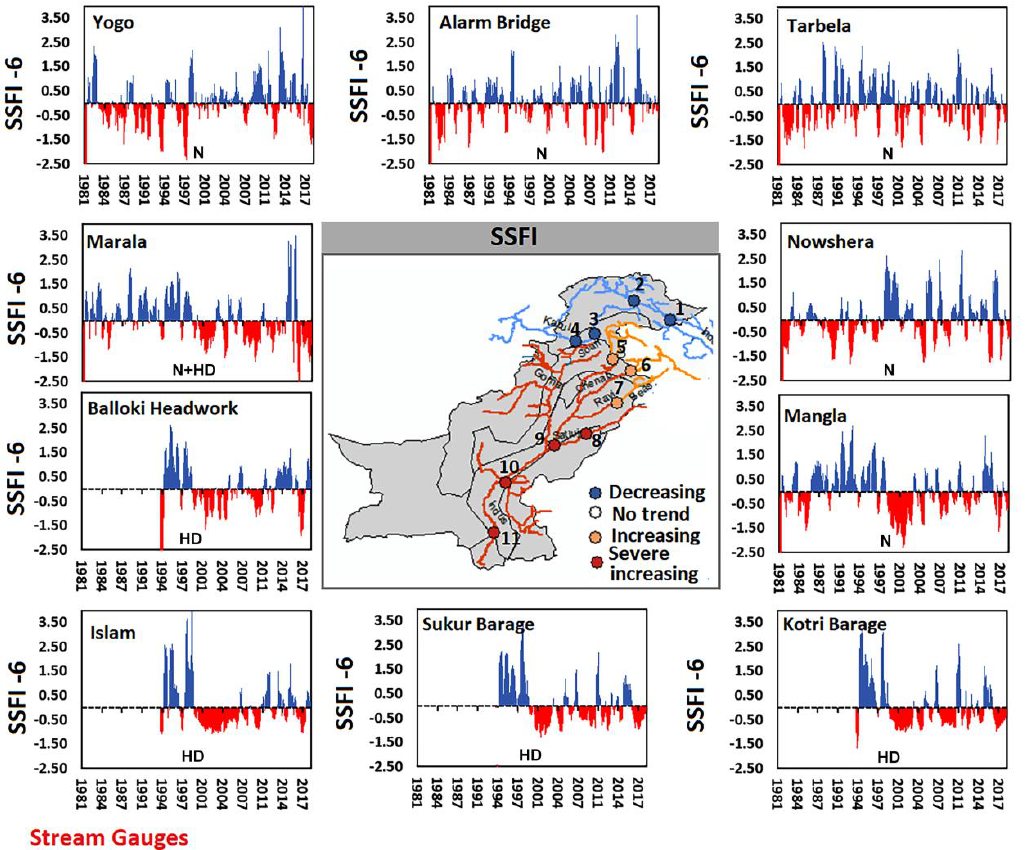
Figure 3. Spatial trend and time series of standardized streamflow index at a 6-month timescale (SSFI-6) for 10 stream gauging stations located in the AEZs. Note: N and HD represent natural and human-disturb zones, respectively.